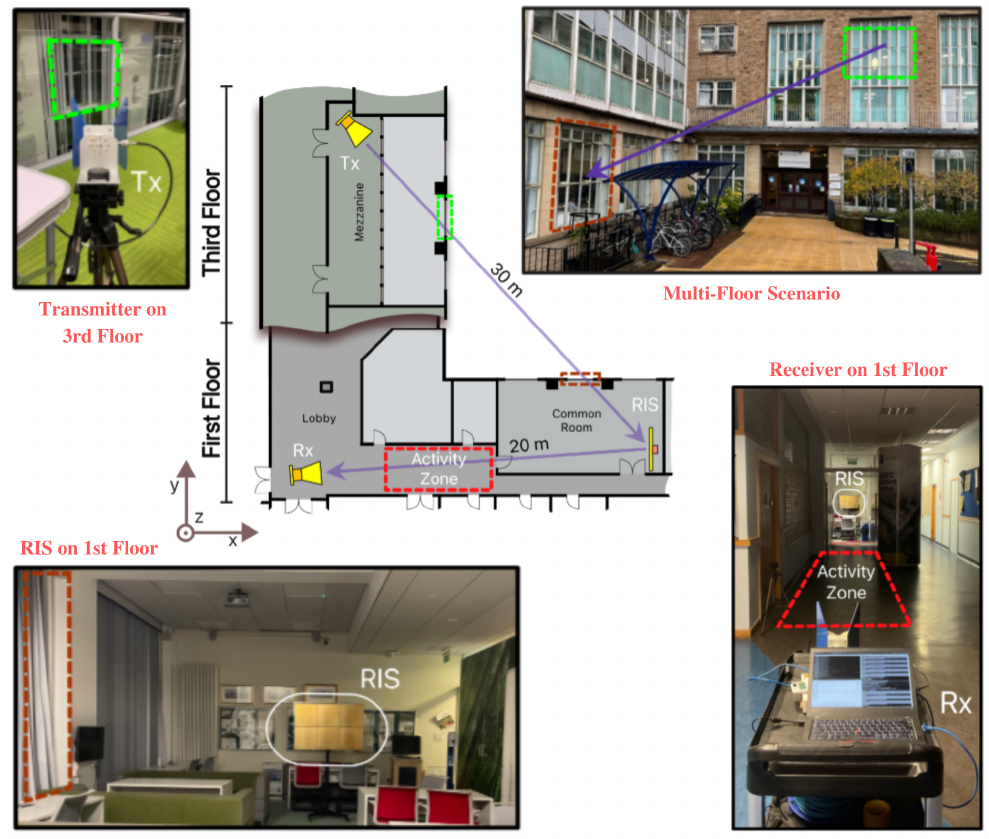
Figure 4. Setup for a multi-floor scenario experiment. IRS and Rx are located on the first floor, while the transmitter is situated on the third floor. Between IRS-Rx and Tx-IRS, a line-of-sight connection is created. In a hallway area between the receiver and the IRS, the activity zone is located